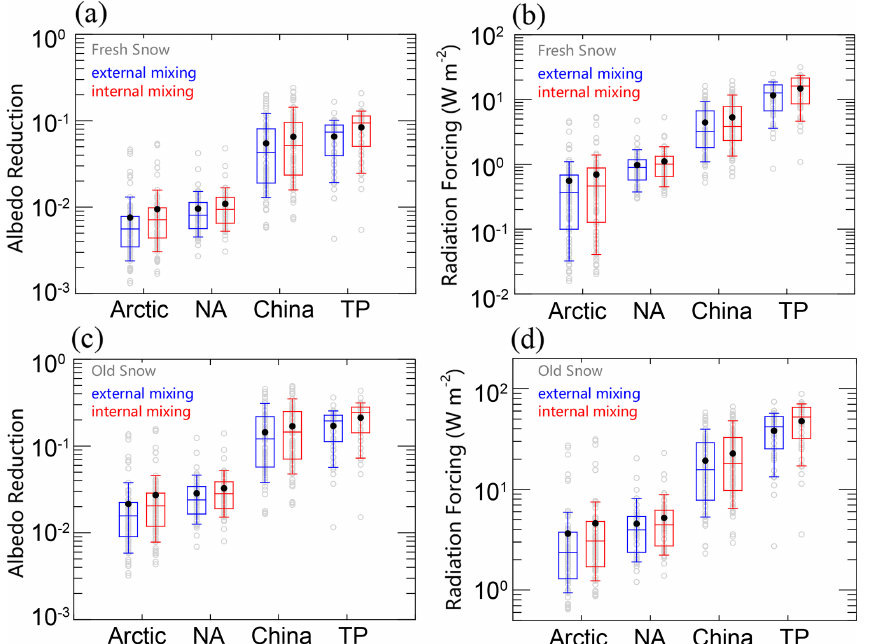
Figure 10. Statistical plots of (a) albedo reduction and (b) radiative forcing in the different regions for fresh snow. Panels (c) and (d) are the same as (a) and (b) , respectively, but for old snow. The boxes denote the 25th and 75th quantiles, the horizontal lines denote the 50th quantiles (median values), the solid dots denote the average values, and the whiskers denote the 10th and 90th quantiles. The in situ data are shown as gray circles.